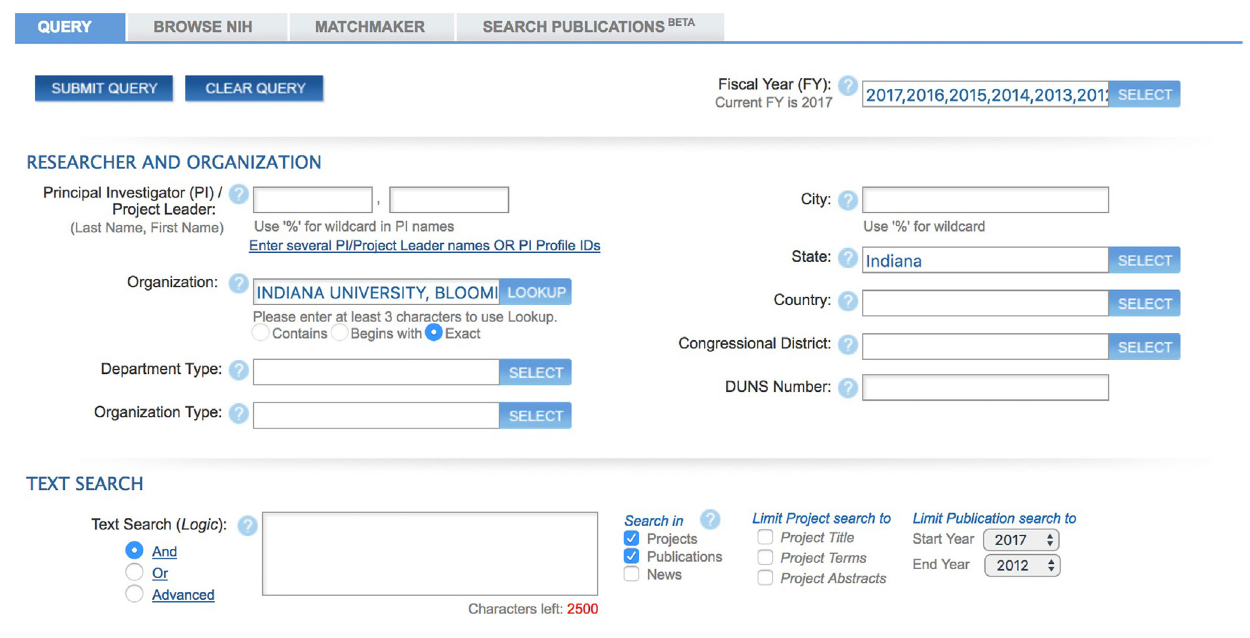
FigUre 2 | NIH RePORTER online search